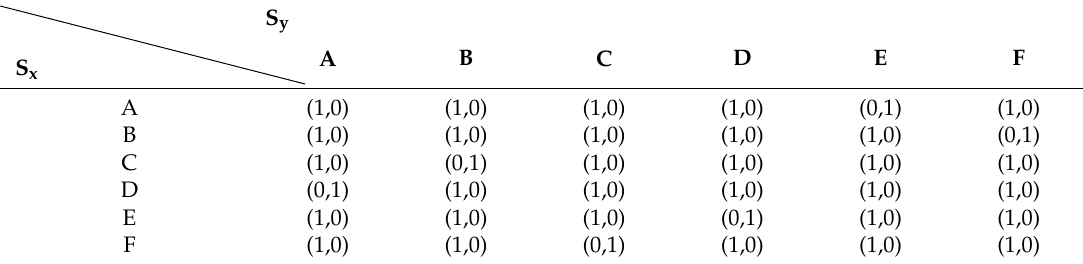
Table 3. Normal Form of a representation game between x and